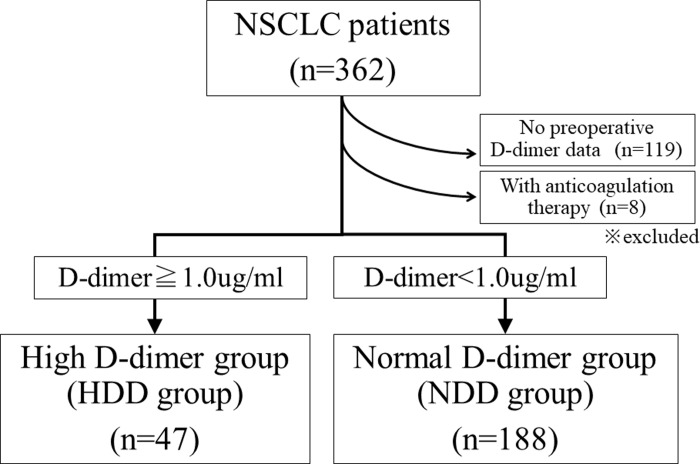
The flow chart of the patients in this study.The patients were divided into 2 groups: a high D-dimer (over 1.0 μg/mL) group (HDD group, n = 47) and a normal D-dimer group (NDD group, n = 188).